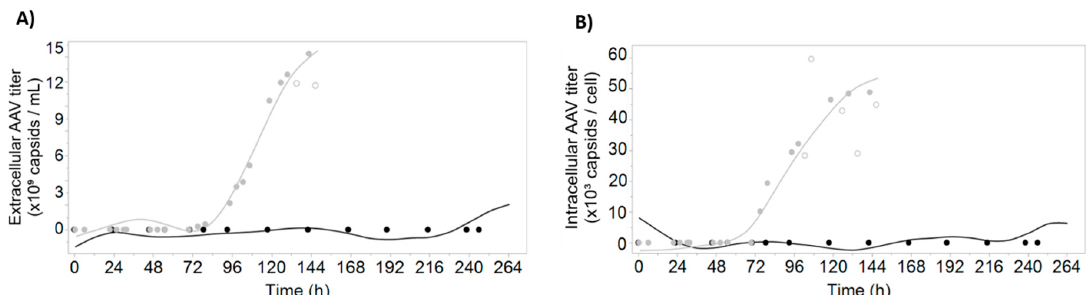
Figure 2. AAV titer predictions for both batches. The growth batch is represented in black and the infected batch is colored in grey. The lines represent model-predicted values; the filled circles represent reference data; the empty circles represent datapoints considered outliers and excluded from modeling. Models were calibrated using the reference data for both batches (filled circles). The prediction data represented by the smooth lines were obtained by applying the model to the real-time di ff erential digital holographic microscopy data. ( A ) Observed and predicted values for extracellular AAV titer; ( B ) observed and predicted values for intracellular specific AAV titer. Model parameters and coefficients are presented in Table S1.